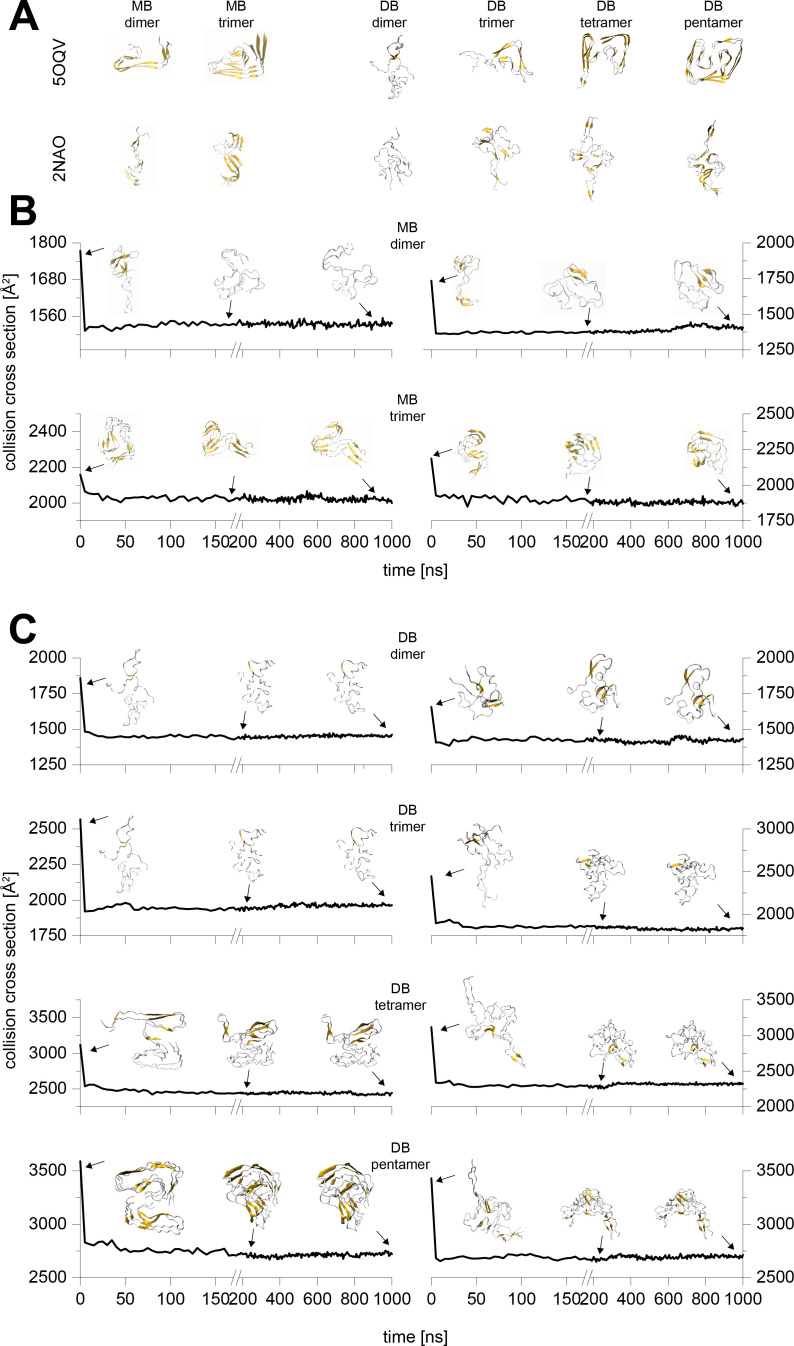
Typical results from the MD simulations of different Aβ42 oligomers cropped out of the PDB structures 5OQV and 2NAO.A shows the respective structure after 10 ns simulation in water. These structures were sent to vacuum simulations. B and C depict the change of the structure's CCS during simulation in vacuum for 1 µs. The insets show exemplary structures after 0 ns, 200 ns and 1000 ns of simulation. The CCS of the 200 and 1000 ns vacuum structures differ by 2% at most, which is below the resolution of the IM-MS. Hence all the remaining calculations were performed to 200 ns.